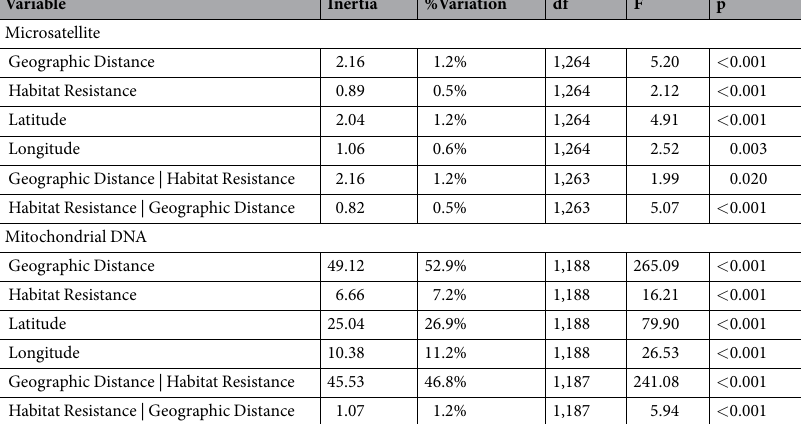
Table 3. Redundancy analysis models examining the effect of geographic distance, habitat resistance, latitude, and longitude on microsatellite and mtDNA genetic differentiation. Conditional tests were conducted to test the effect of geographic distance on genetic variation while controlling for habitat resistance along with the reciprocal test. Total variance (Inertia), percent of the variation explained (% Variation), degrees of freedom (df), F-Ratio (F), and p-values (p) are presented for each